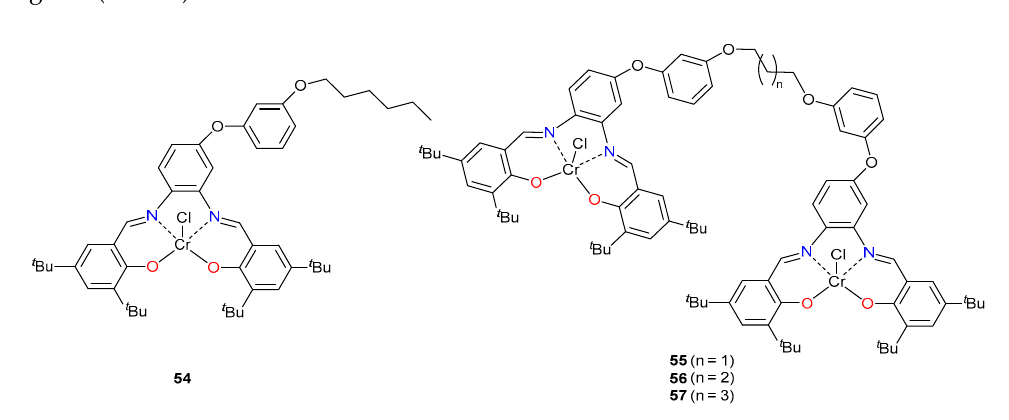
Figure 9. Mono- and dinuclear Cr(III)-salphen complexes 54–57 [50].